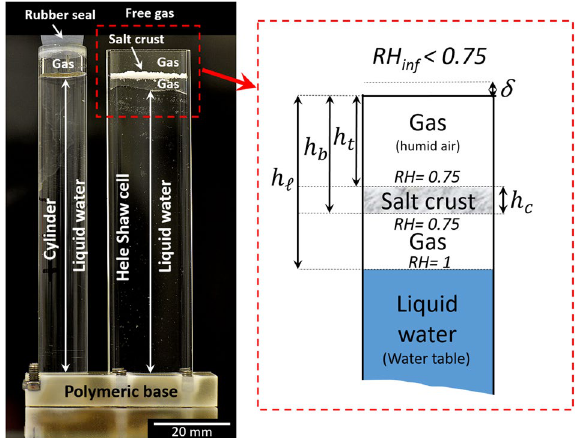
Figure 1. Experimental set-up. A salt crust is suspended in a Hele-Shaw cell (20 mm wide, 100 mm high, with an aperture of 2 mm) with liquid water at some distance below the crust. The cell is open at the top to a relatively dry air, which induces evaporation. The Hele-Shaw cell is connected through its polymeric base to a cylinder containing liquid